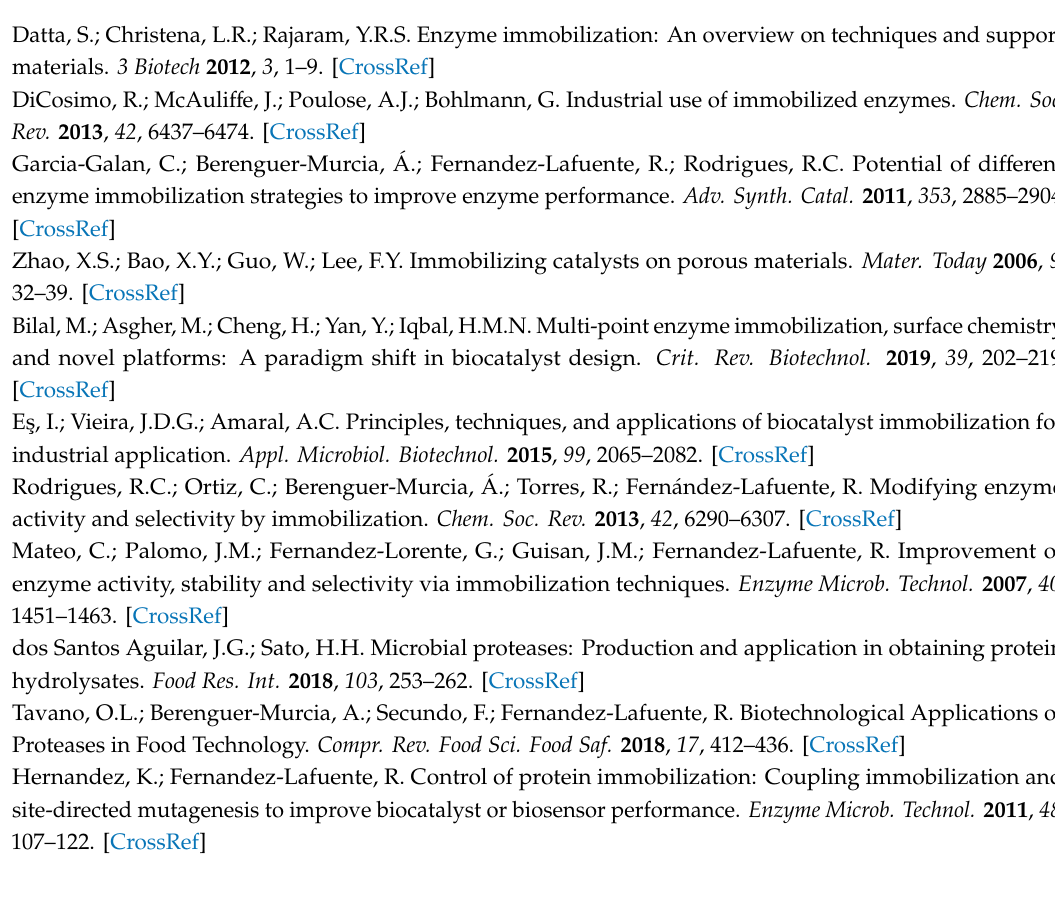
Figure S1: Thermal inactivation profiles of free and immobilized Novo-Pro D (NPD) at 50 ◦ C and pH 8.0 (0.1 M sodium phosphate bu ff er). Continuous line: Sadana–Henley thermal inactivation model [45] fitted to the experimental data. Figure S2: Thermal inactivation profiles of soluble and immobilized Novo-Pro D (NPD) at 50 ◦ C and pH 8.0 (0.1 M sodium phosphate bu ff er). Continuous line: Sadana–Henley thermal inactivation model [45] fitted to the experimental data. Figure S3: Immobilization profiles of Novo Pro-D (NPD) on agarose-glyoxyl (20 ºC, pH 10.0, protein load o ff ered of 66.3 mg / g